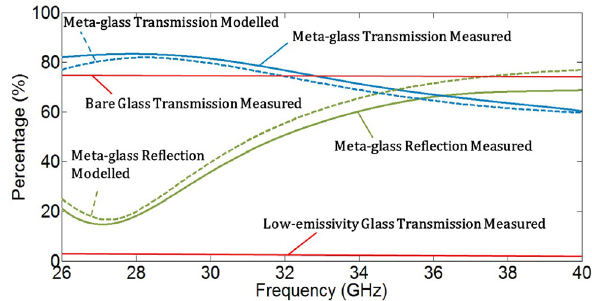
Figure11: MeasuredandModelledRFtransmissionandreflectionof the bare glass substrate, low-emissivity glass and the designed meta-glass comprising of optimized m-DM spectrally selective (DMDMD)coatingwithatotalof30nmAgoneachsideundernormal incident.